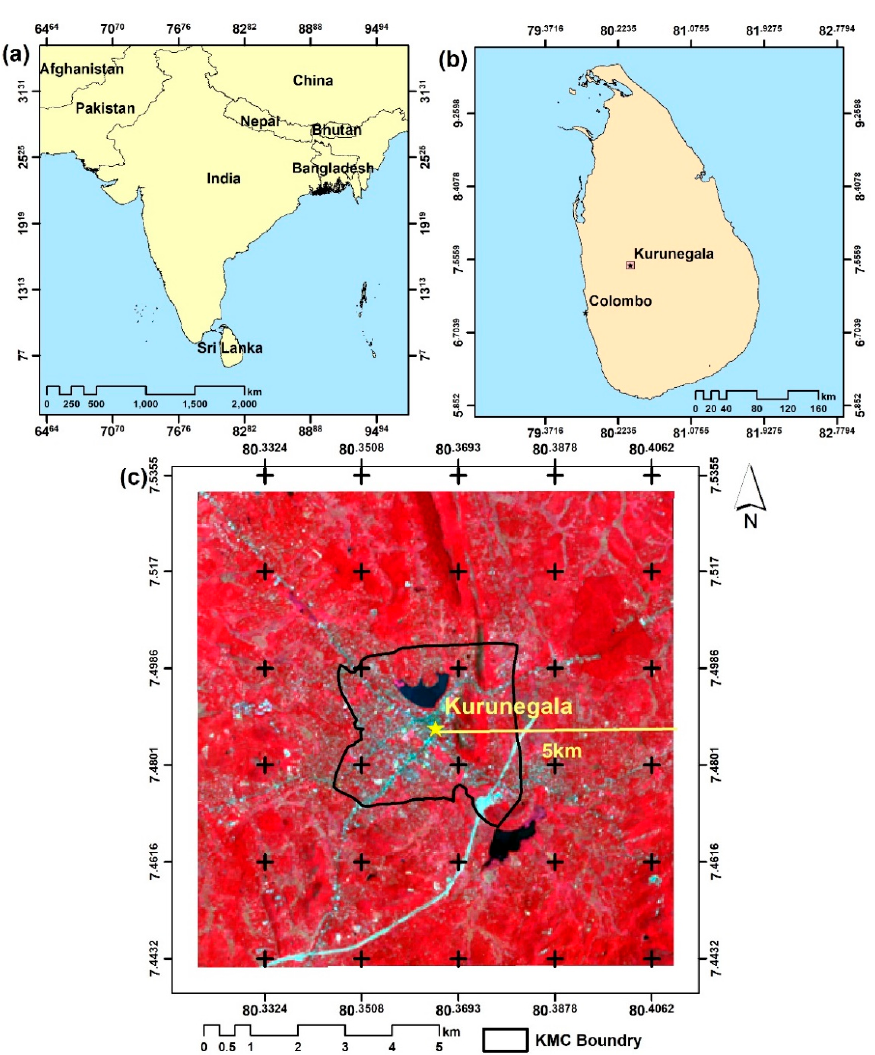
Figure 1. The study area in Sri Lanka: ( a ) map from part of South Asia; ( b ) location of the Kurunegala Urban Area (KUA) in Sri Lanka; and ( c ) Landsat-8 false-colour composite image (bands 5, 4 and 3) of 2019 showing the study area.